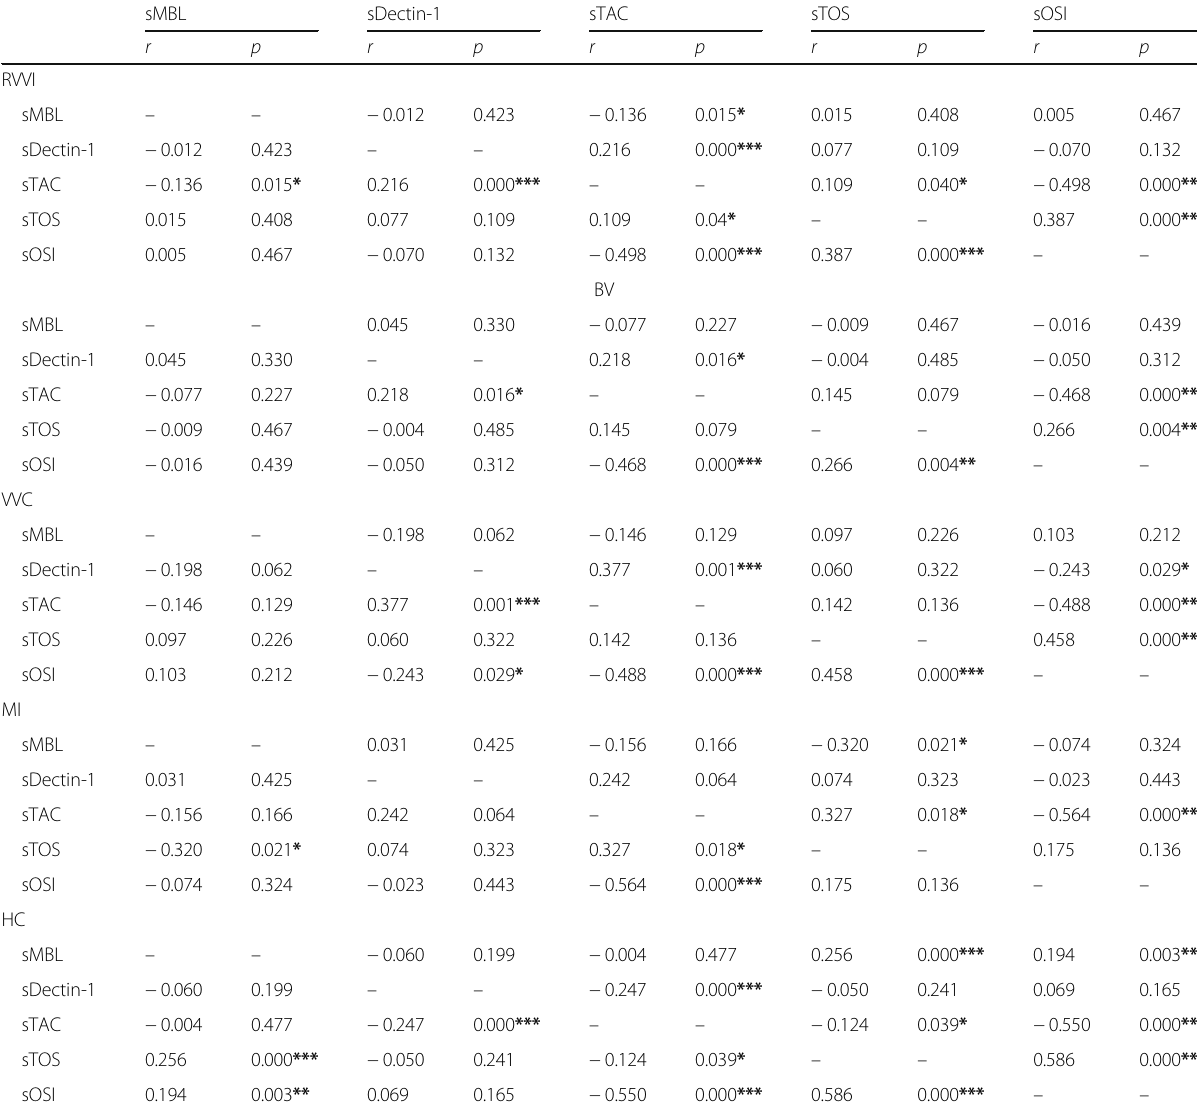
Table 2 Correlation analysis of serum biomarkers in RVVI, RVVI types, and